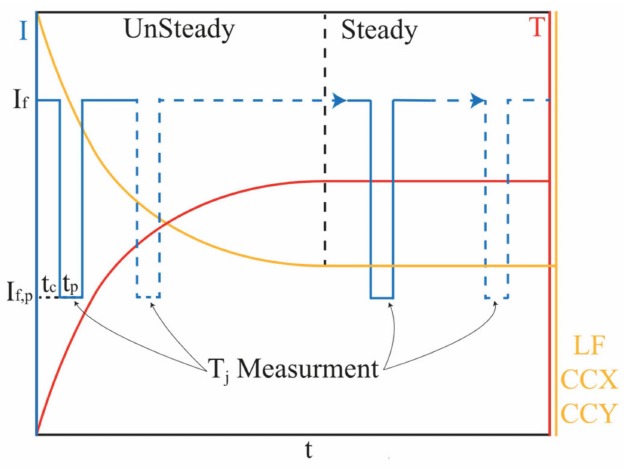
Figure 3. Illustration of the transient test phase (red curve shows the trend of temperature rise of the junction, and the yellow curve assimilates the trend of optical